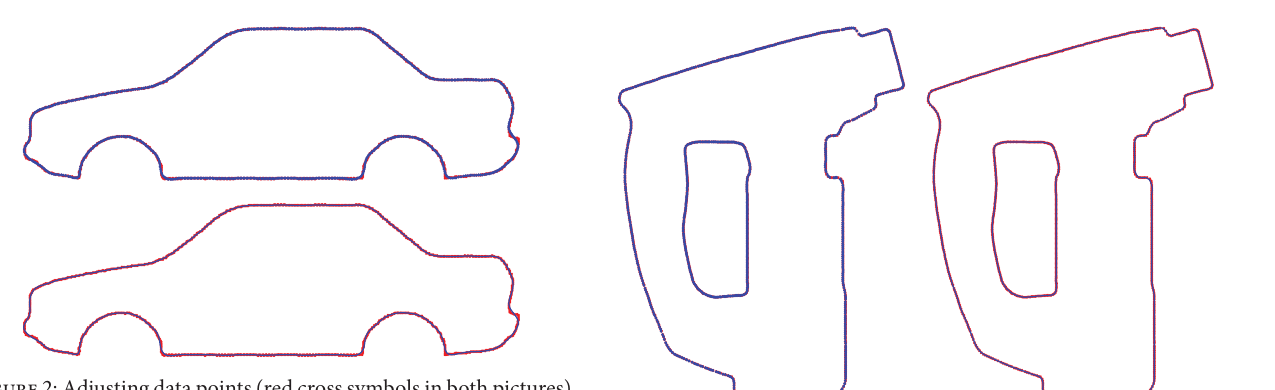
Figure 2: Adjusting data points (red cross symbols in both pictures) of a car body side profile with our method: (top) reconstructed data points (blue empty circle symbols); (bottom) approximating spline curve (blue solid line).